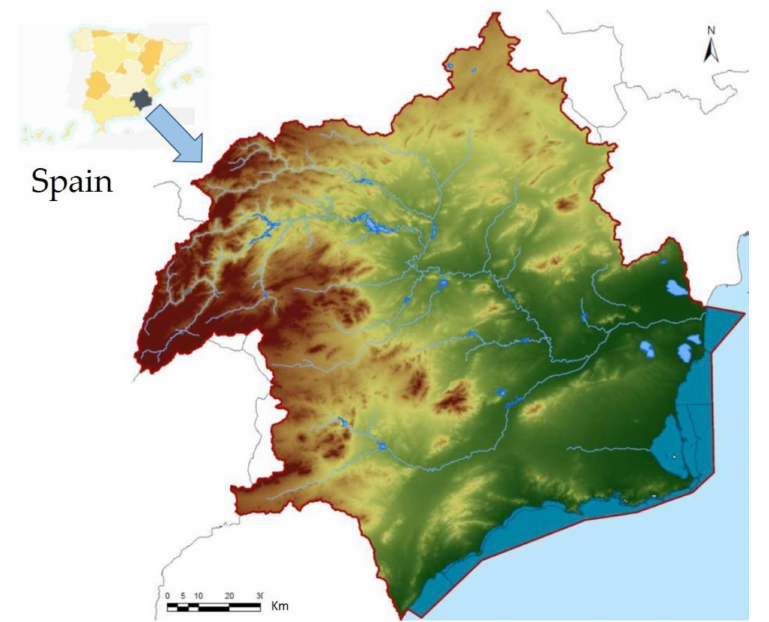
Figure 2. Segura River